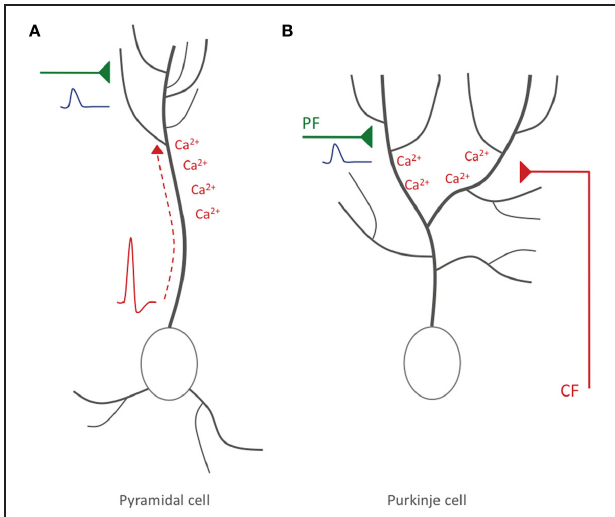
FIGURE 3 | Hebbian-style and non-Hebbian STDP. (A) Hebbian STDP in hippocampal and neocortical pyramidal cells. Action potentials are elicited near the soma and backpropagate into the dendrite, where the accompanying depolarization leads to calcium influx (red). The timing relative to incoming EPSPs (blue) evoked at glutamatergic synaptic inputs (green) determines whether LTP or LTD is induced. (B) Non-Hebbian STDP in cerebellar Purkinje cells. Here, somatic/axonal action potentials do not actively invade the dendrite. Rather, CF activation causes local dendritic calcium spikes. LTD results if PF-EPSPs precede CF activity. In hippocampal/neocortical circuits this activation sequence (synaptic activity—spike) promotes LTP